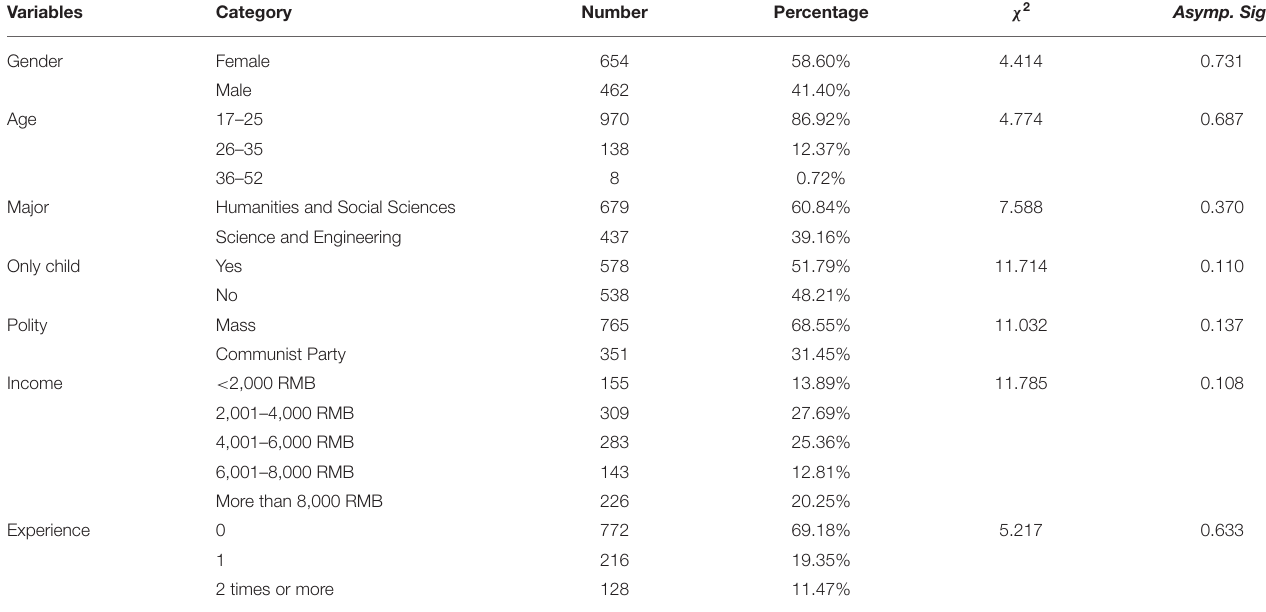
TABLE 2 | Demographic characteristics of the sample and non-parametric test results. Variables